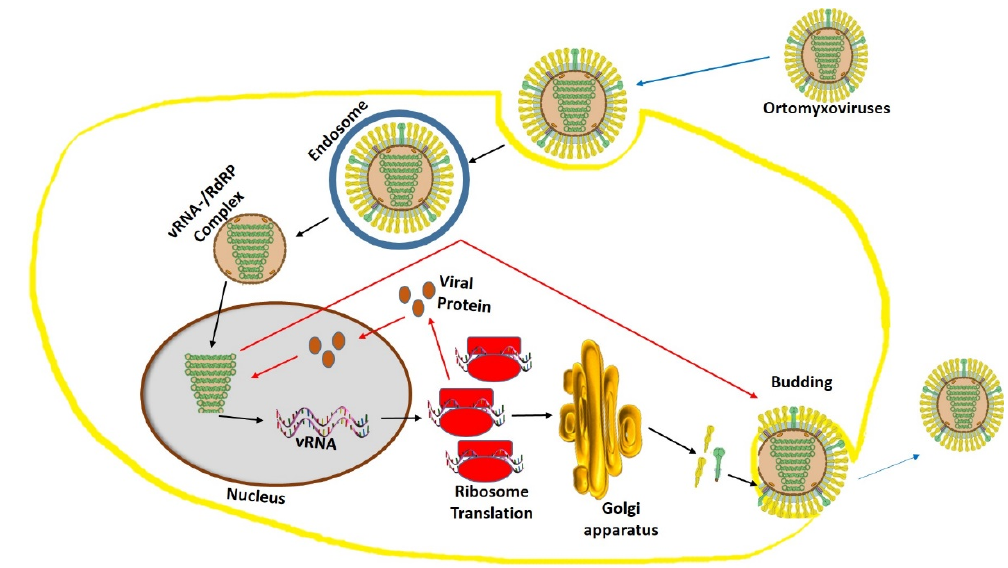
Figure 3. Orthomyxovirus structure and replication mechanism. The Orthomyxovirus structure in this figure has been modified from the source